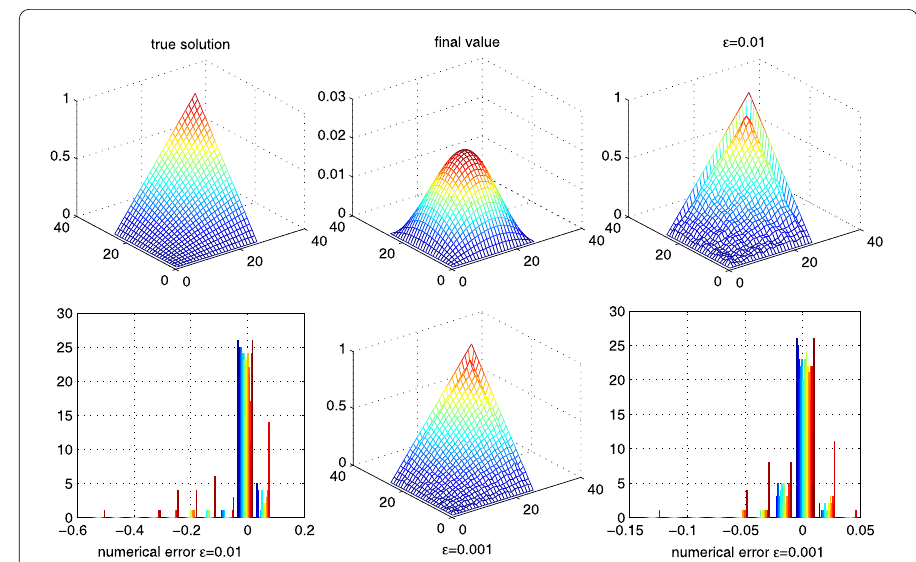
Figure 4 The comparison of numerical effects between the exact solution and its regularized solution for Example 4.